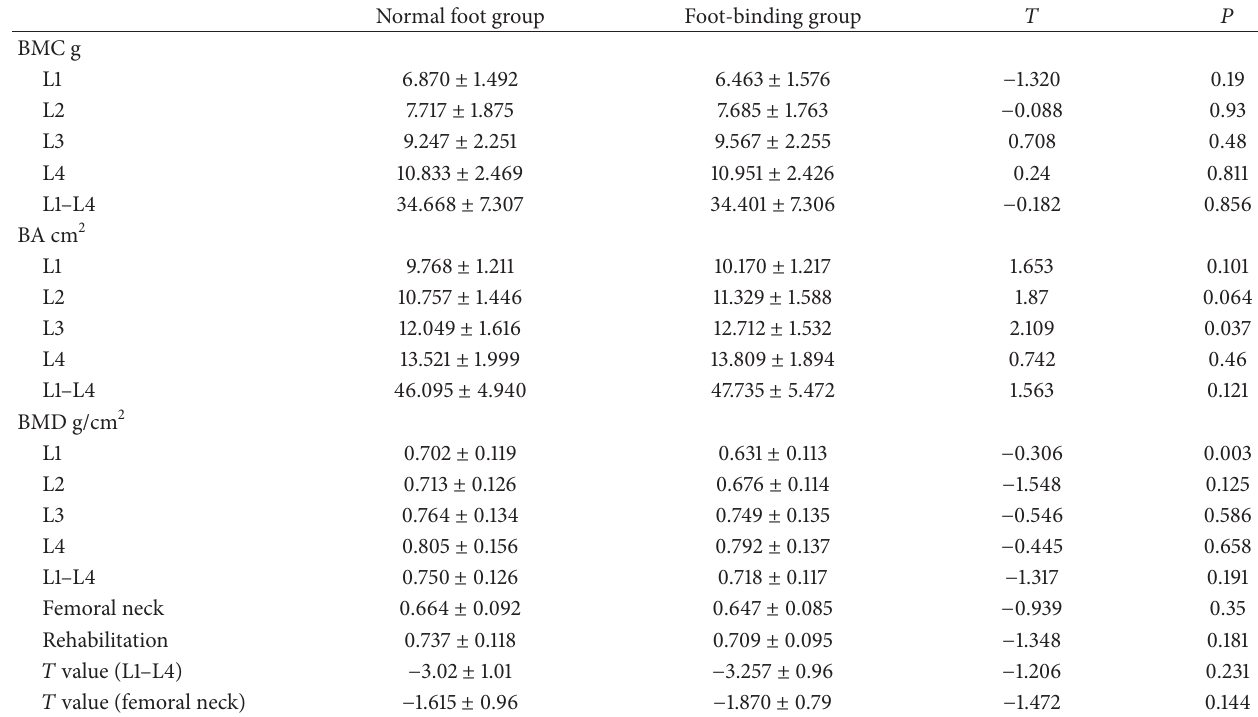
Table 6: Lumbar spine and hip DXA data analysis between normal foot group ( 𝑛 = 46 ) and foot-binding group ( 𝑛 = 56 ).